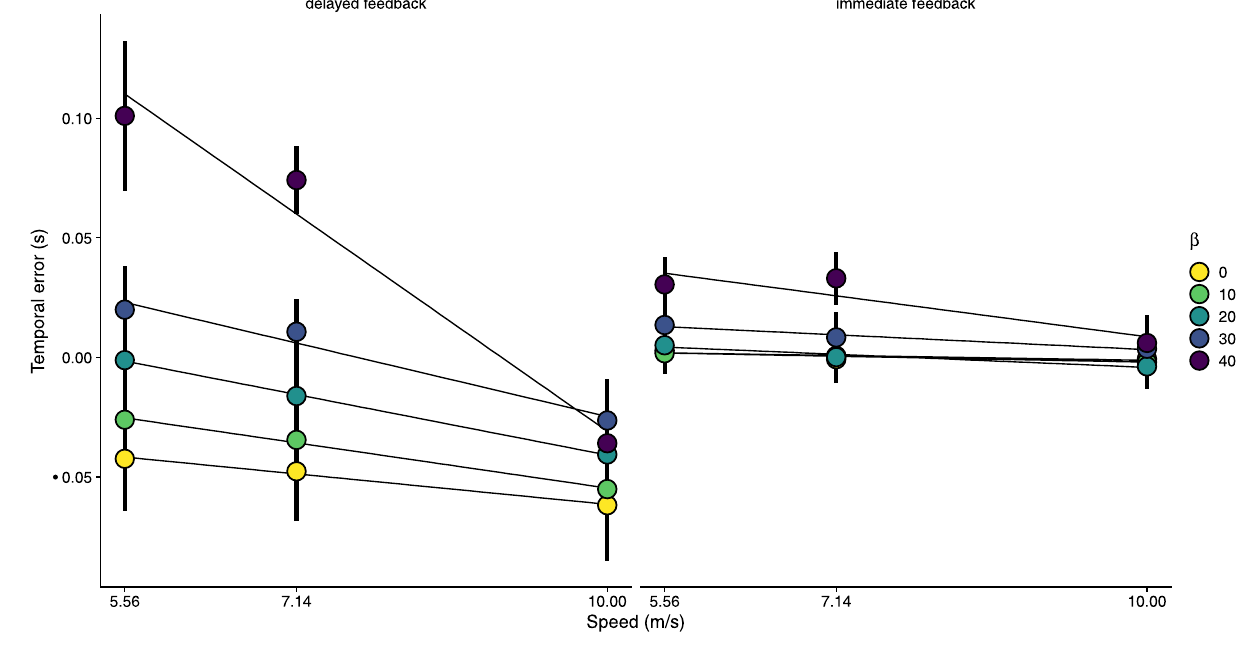
Figure 5. Temporal error as a function of target speed for the two conditions (different panels) and split per approaching angle of trajectory ( β , color-coded). Negative values denote later